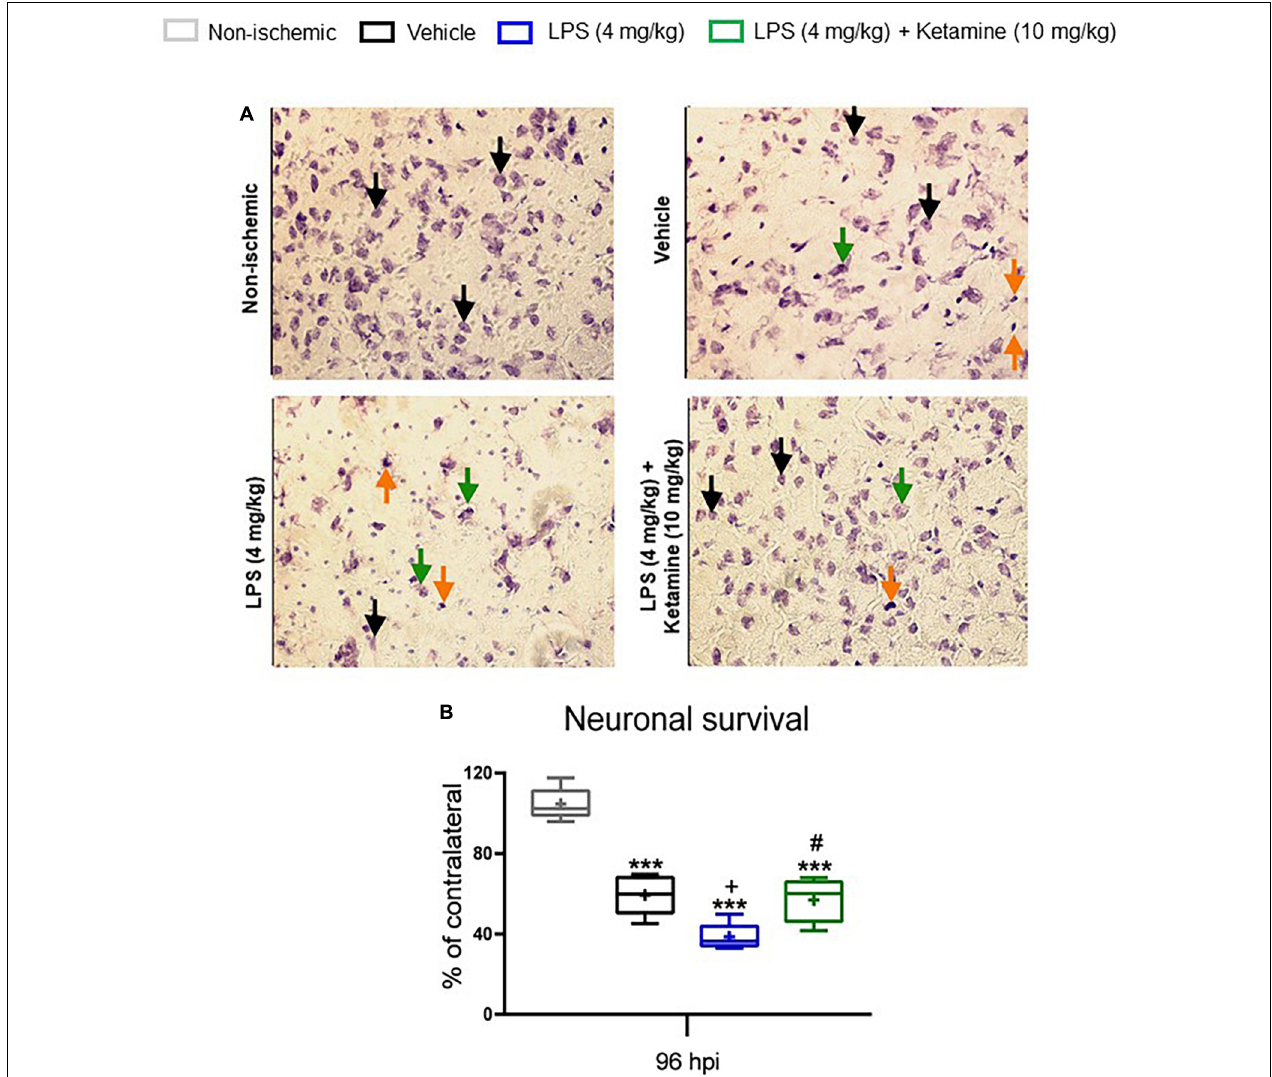
FIGURE 4 | Effects of LPS and ketamine on post-ischemic neuronal survival. (A) Neuronal survival assessed by Nissl staining in the ischemic striatum, i.e., the core of the middle cerebral artery territory, of mice exposed to sham surgery or transient MCAO. The ischemic animals were treated with vehicle or LPS (4 mg/kg) at 24 hpi followed by vehicle or ketamine (10 mg/kg) 30 min later. Mice were sacrificed at 96 hpi. The density of surviving neurons in the ischemic striatum was expressed as percentage of the density of neurons in the contralateral non-ischemic striatum. (B) Note that transient MCAO markedly reduced neuronal density in the ischemic striatum. LPS-induced sepsis further decreased neuronal density, whereas additional ketamine increased neuronal survival. Data are medians (lines inside boxes)/means (crosses inside boxes)_interquartile ranges (IQR; boxes) with minimum/maximum values as whiskers (n D 5 animals/group). In (A) surviving neurons, presumably apoptotic cells and necrotic cells were labeled with black, orange and green arrows, respectively. Only medium-sized surviving neurons with intact shape were counted. *** P < 0.001 compared with non-ischemic sham; + P < 0.05 compared with ischemic vehicle; # P < 0.05 compared with ischemic LPS. Scale bar: 100